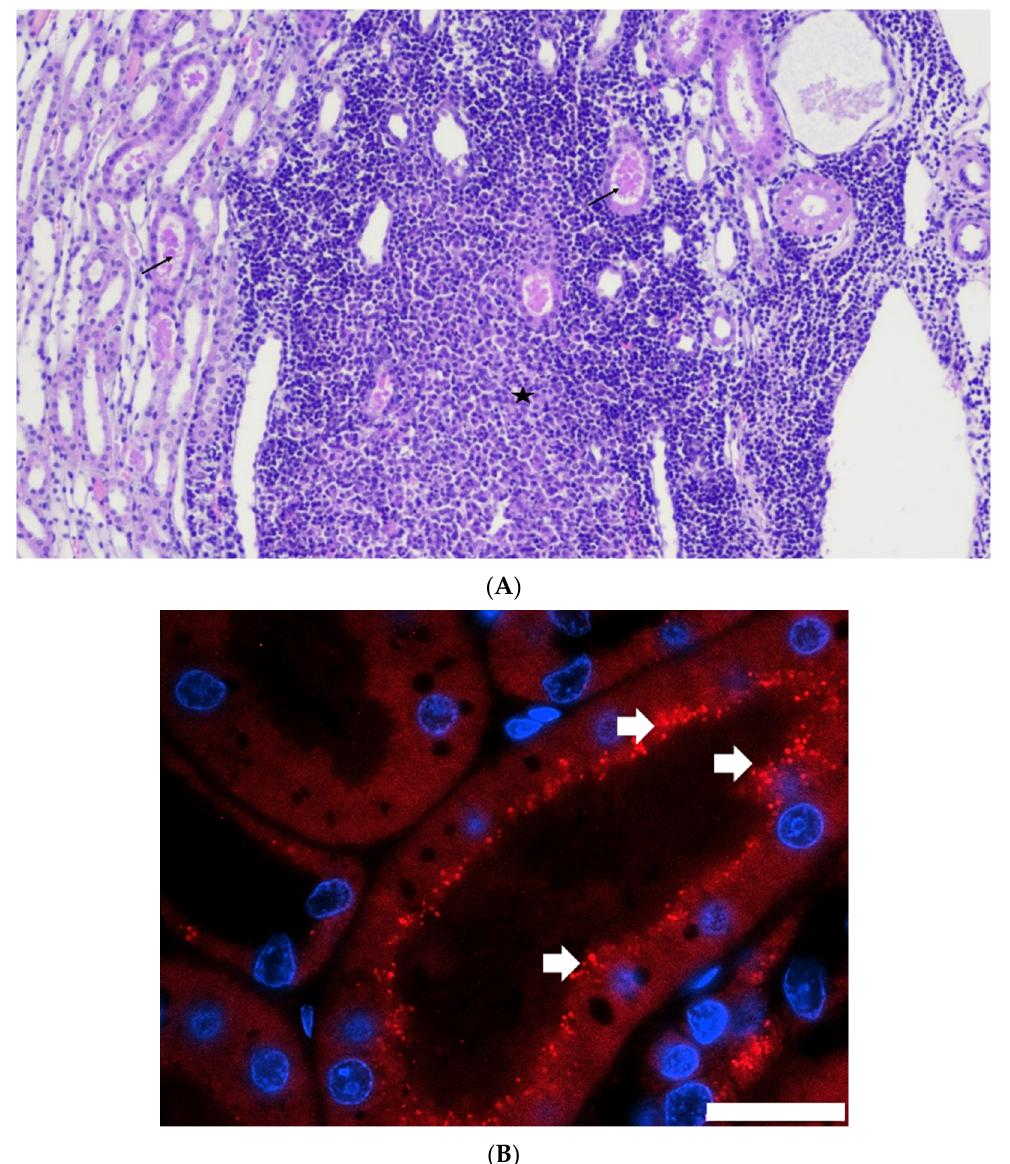
Figure 6. ( A ) Histological section of kidney stained by H&E showing focal tubulointerstitial nephritis (star) and multifocal tubular casts (arrows) in an FeMV-infected cat (day 24). ( B ) Histological section of kidney from an FeMV-infected cat 14 days post infection. Section was stained with a polyclonal rabbit antibody directed against the viral nucleoprotein followed by an AlexaFluor594-conjugated anti-rabbit secondary antibody. Virus-specific signals appear as red dots (see white arrows) and are located at the apical surface of tubular epithelial cells. An FeMV-negative tubule can be seen in the upper left. Cell nuclei were stained with DAPI and are shown in blue. Scale bar represents 20 µ